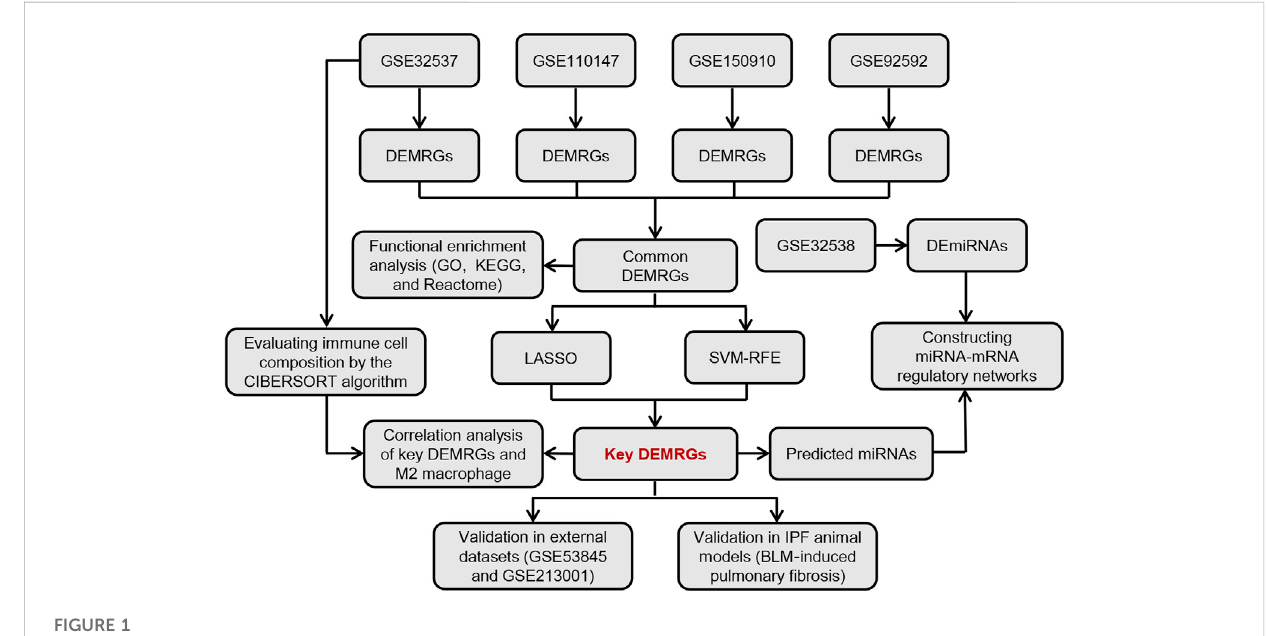
FIGURE 1 The overall fl ow chart of this study.